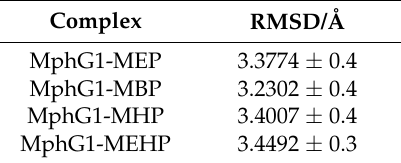
Figure 5. The profile of root mean square deviation (RMSD) values during MD simulation for each MphG1-MAP complex (0–6000 ps). Table 2. The RMSD values for the complexes after MD simulation.